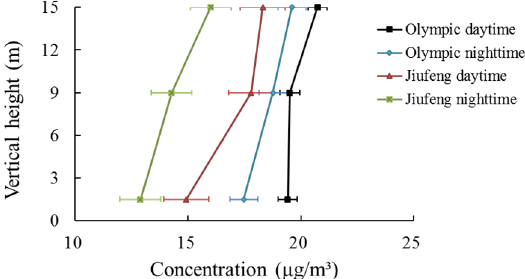
Figure 3. The average PM 2.5 SO 42 − concentration at the various heights and sites. The average PM 2.5 SO 42 − concentration at the heights of 1.5 m, 9 m, and 15 m during the day and night in May 2013 in Olympic Forest Park and Jiufeng National Forest Park. The error bars are the standard errors at the various heights.